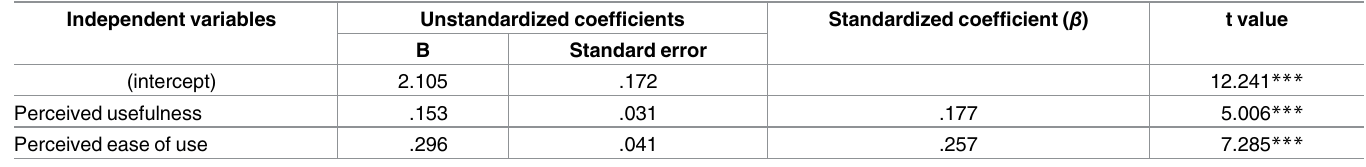
Table 6. Path analysis coefficient summaryof “perceived ease of use” and “perceived usefulness” to “usage intention”. Independent